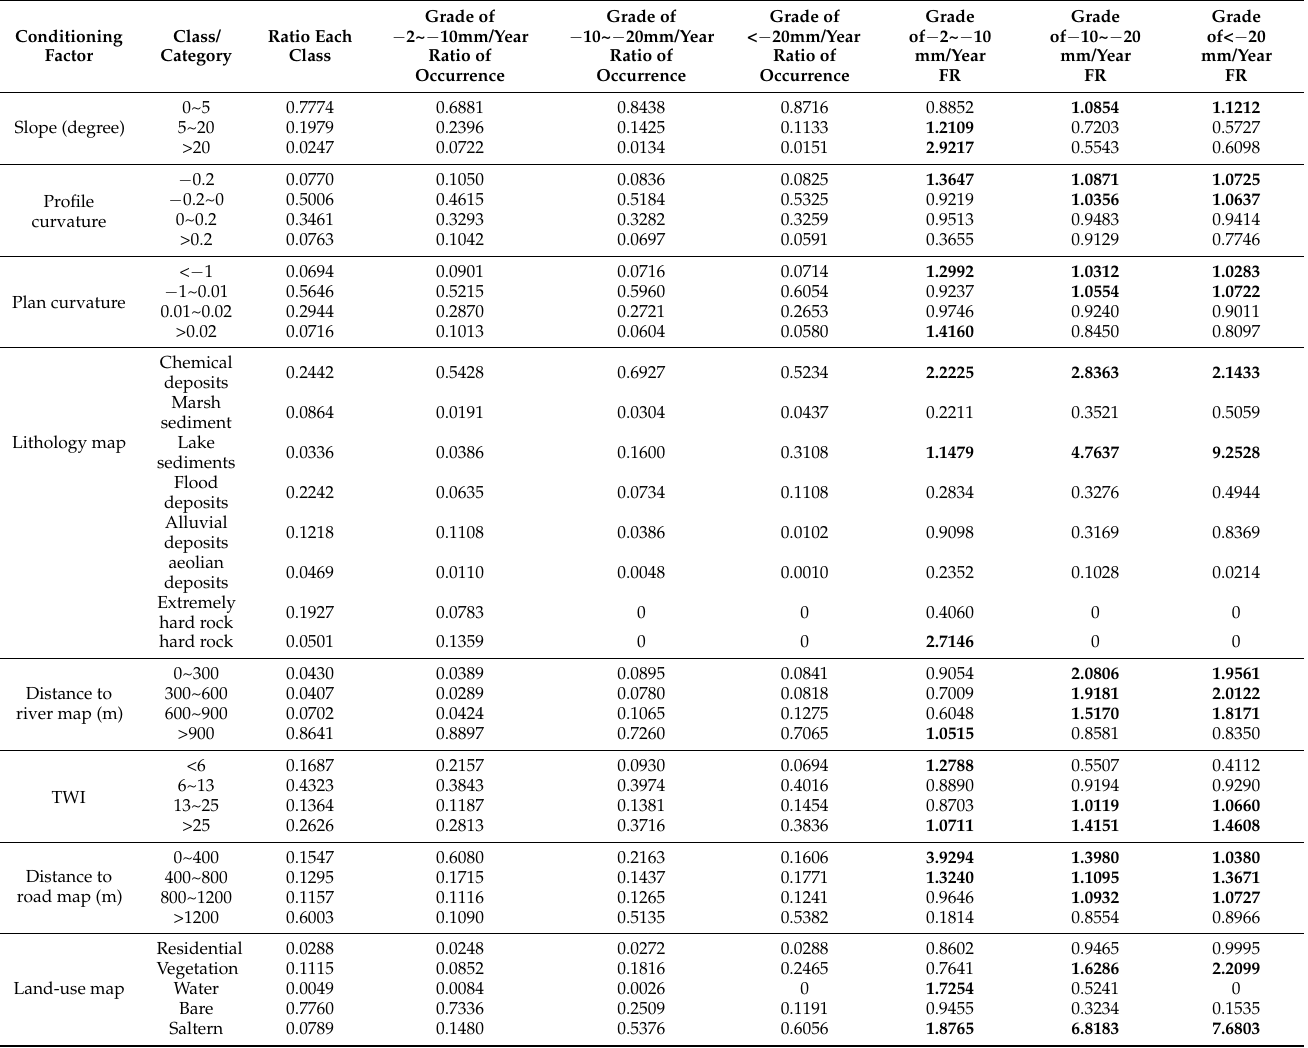
Table 4. Relationship between different land subsidence intensities and conditioning factors using frequency ratio (FR)